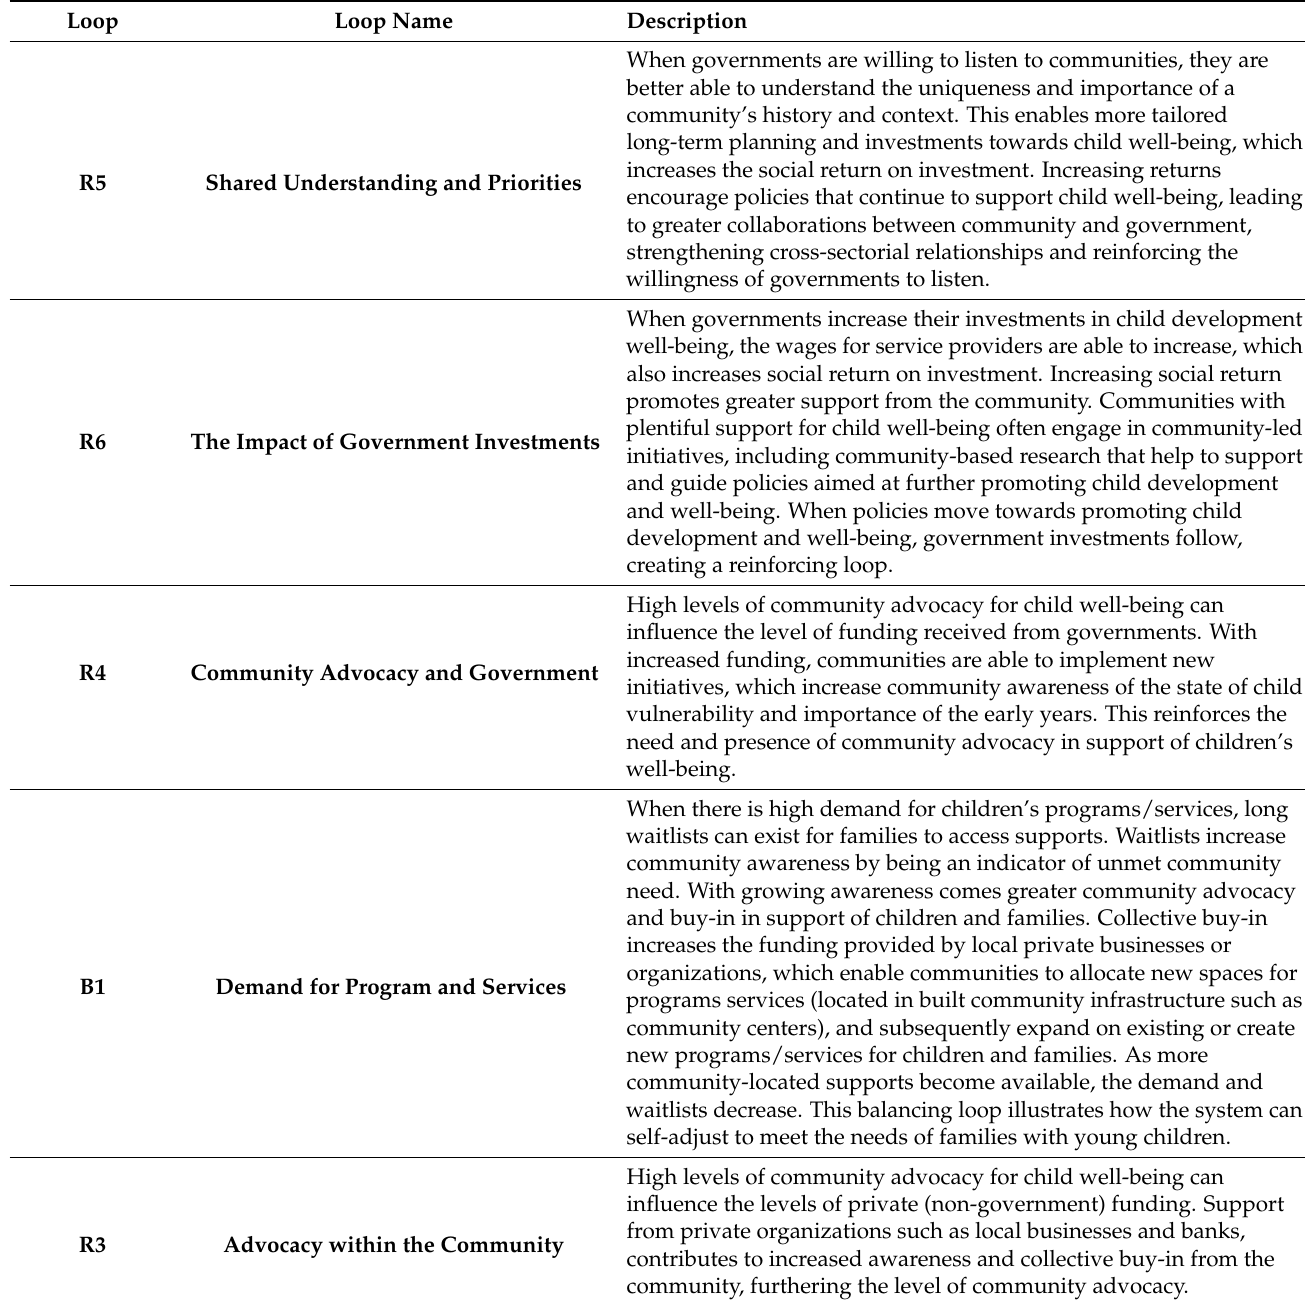
Table 2. Summary of key feedback loops in the community/neighborhood